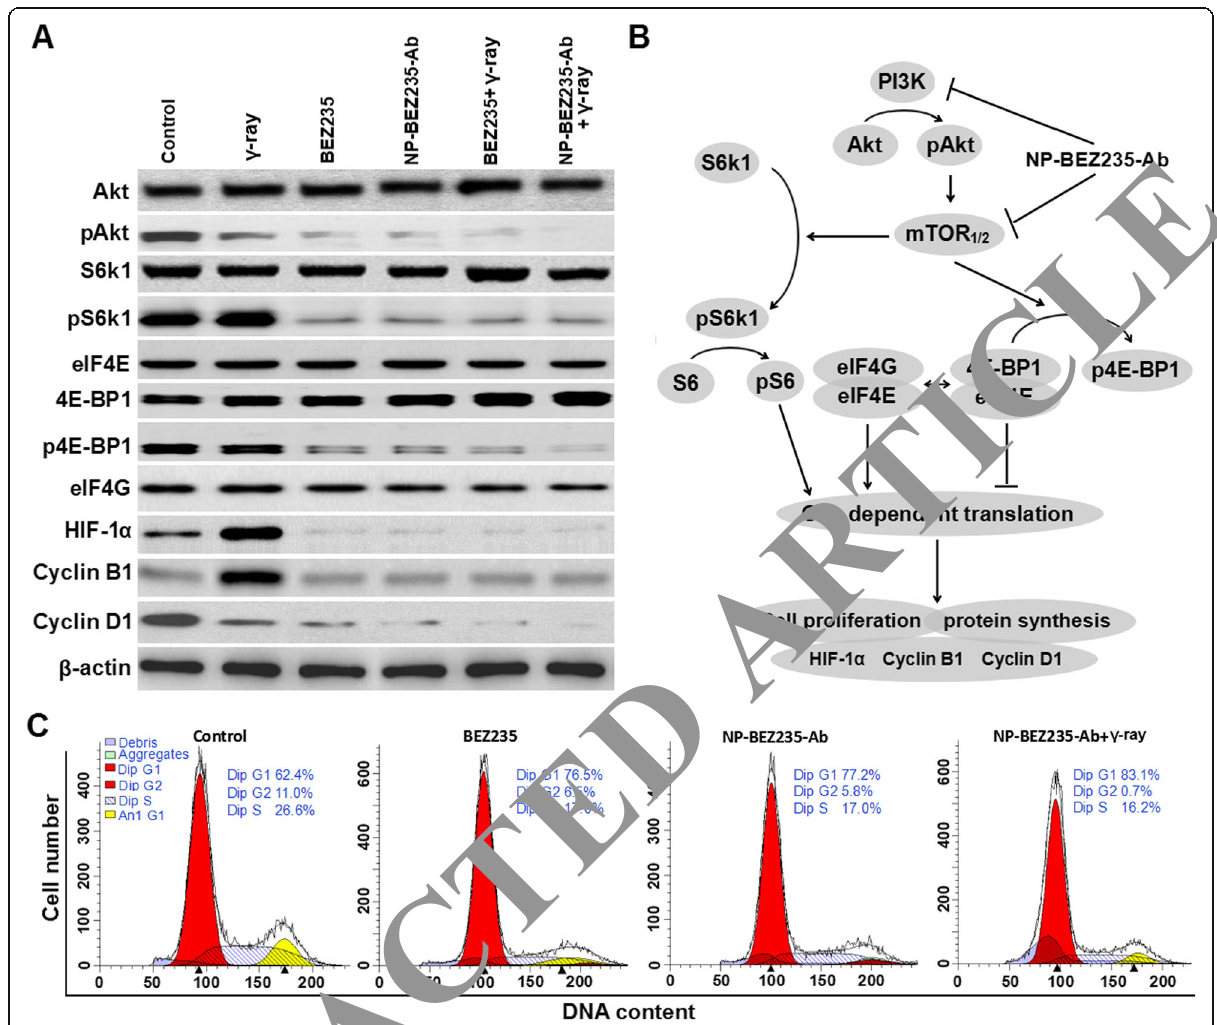
Fig. 8 The role of NP-BEZ235-Ab in the PI3K/AKT/mTOR pathway in of HepG2 cells. a Western blots were performed, using antibodies to PI3K/ AKT/mTOR pathway proteins and cyclin-related regulatory protein, with β -actin as a loading control. NP-BEZ235-Ab inhibits PI3K/Akt/mTOR pathway more than does BEZ235. b Diagram of the hypothetical effects of NP-BEZ235-Ab on the PI3K/Akt/mTOR pathway in HepG2 cells. c Cell cycle distribution of HepG2 cells in the flow cytometric analysis of HepG2 cells in each group for 24h. The data represent three independent